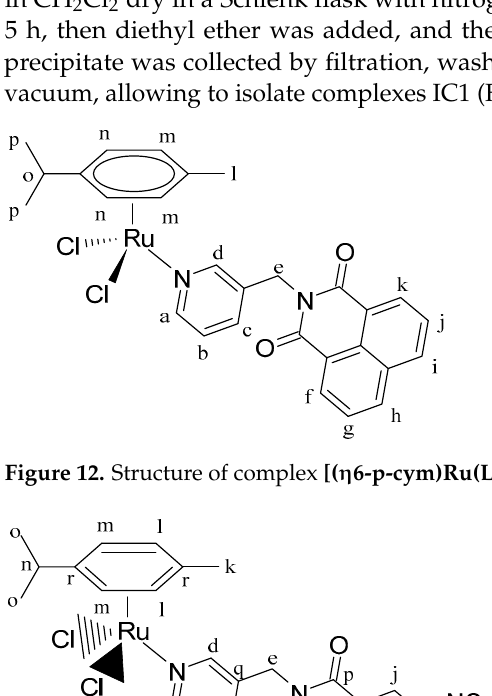
Figure 12. Structure of complex IC1.